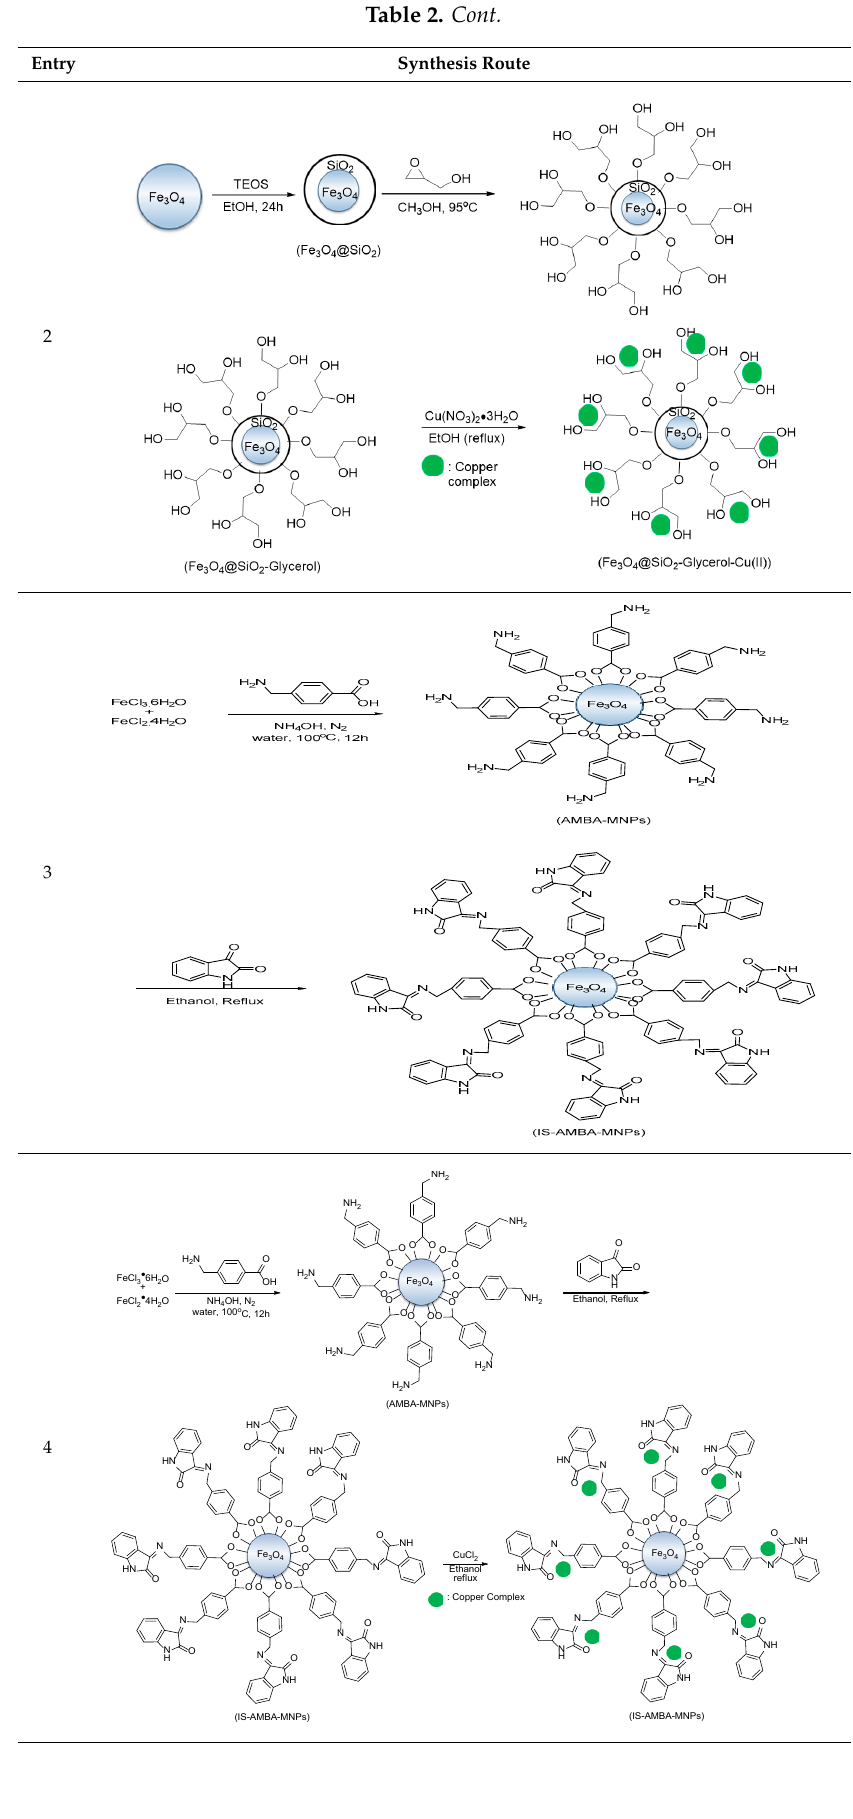
5 6 Table 3. The various type of Maghemite-supported Copper nanoparticles catalyzed synthesis of biphenyl